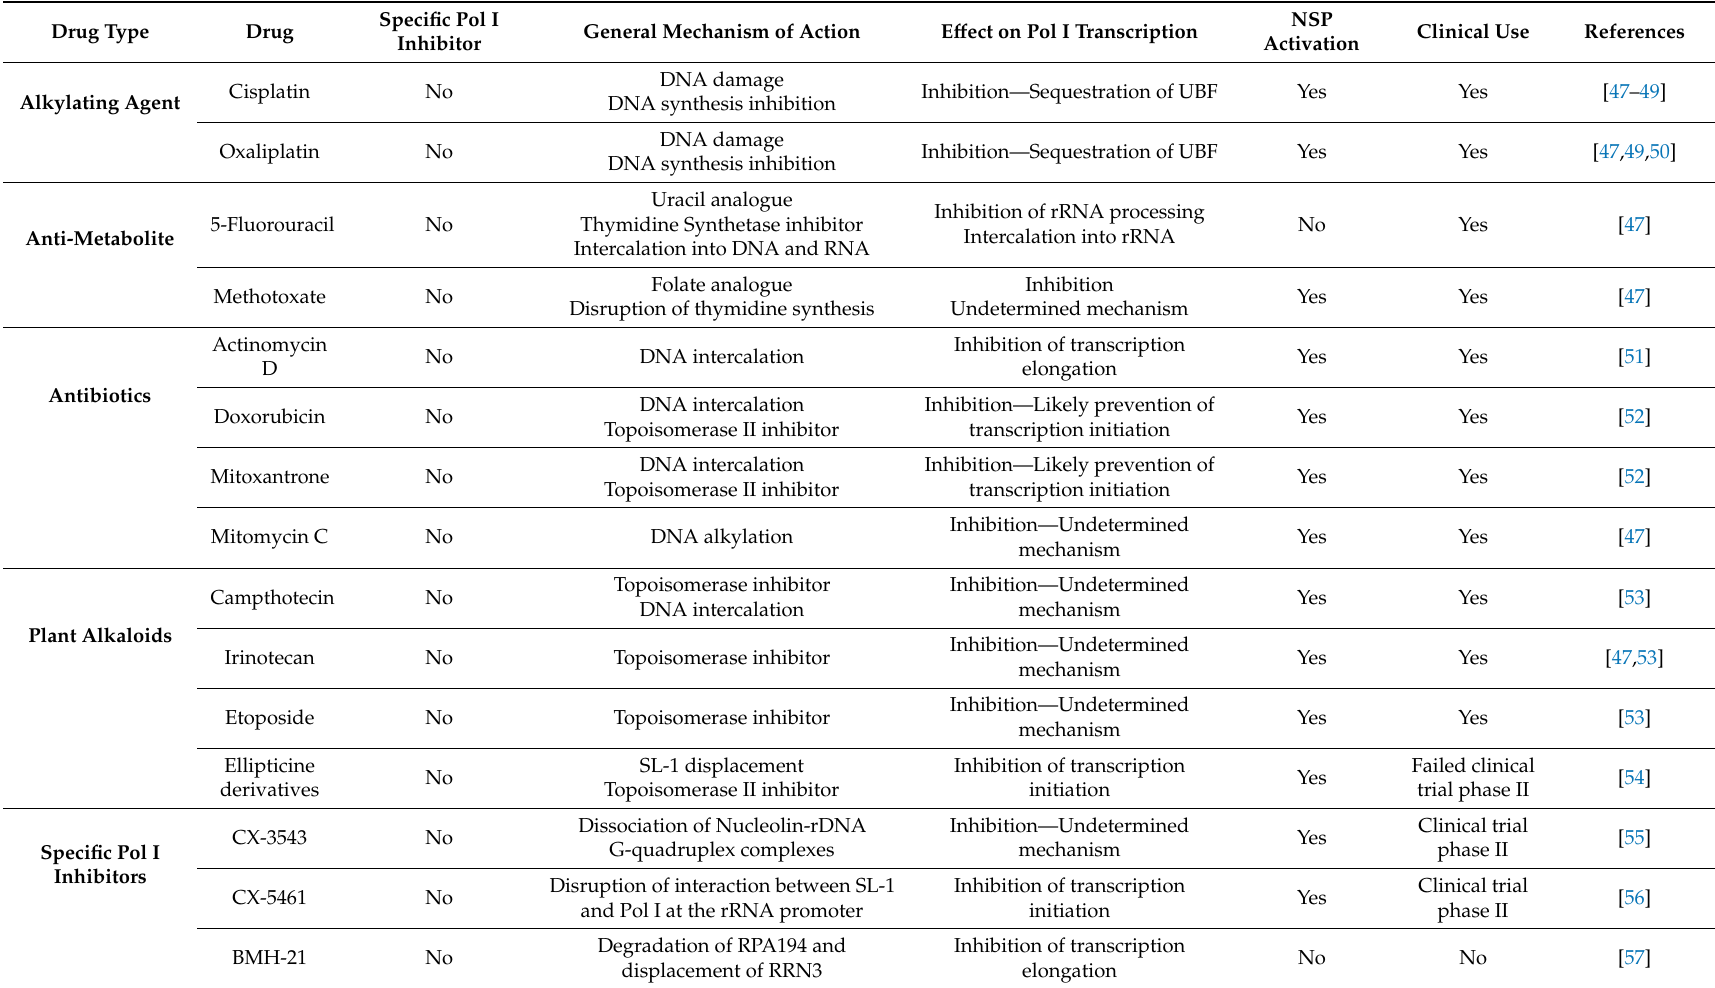
Table 1. Chemotherapeutics a ff ecting Pol I